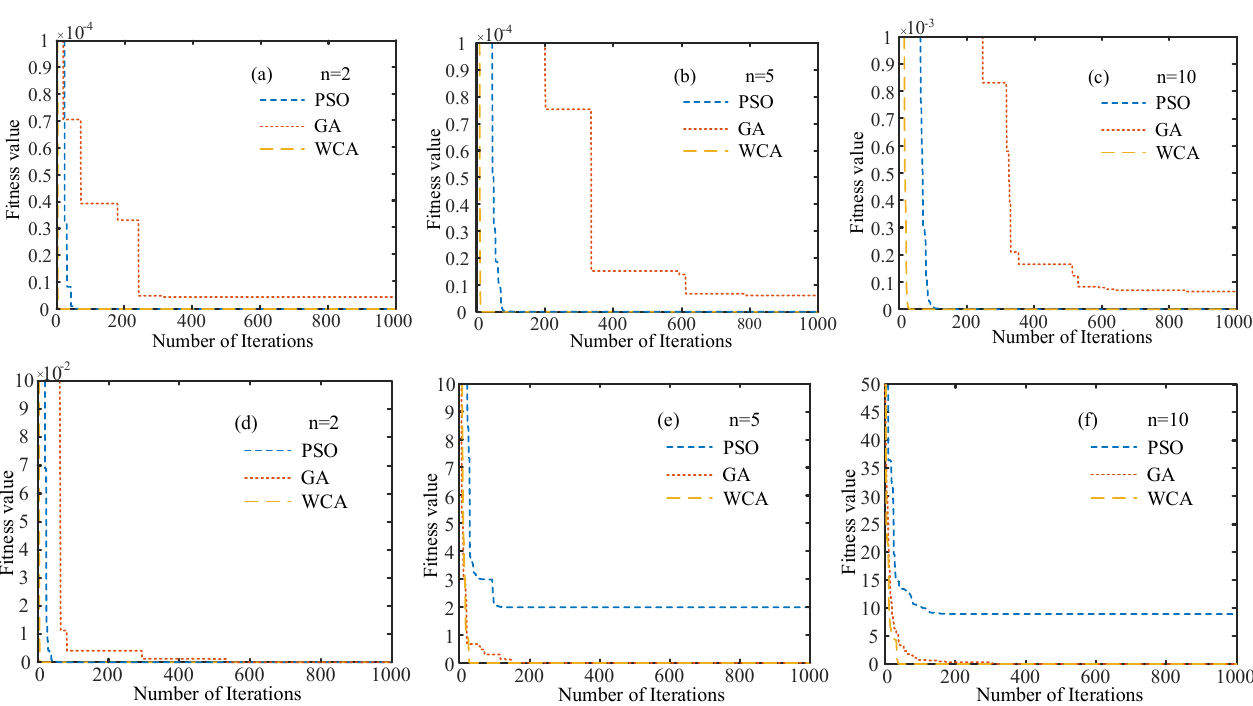
Figure 6. Convergence curve, where ( a – c ) are based on Sphere function and ( d – f ) are based on